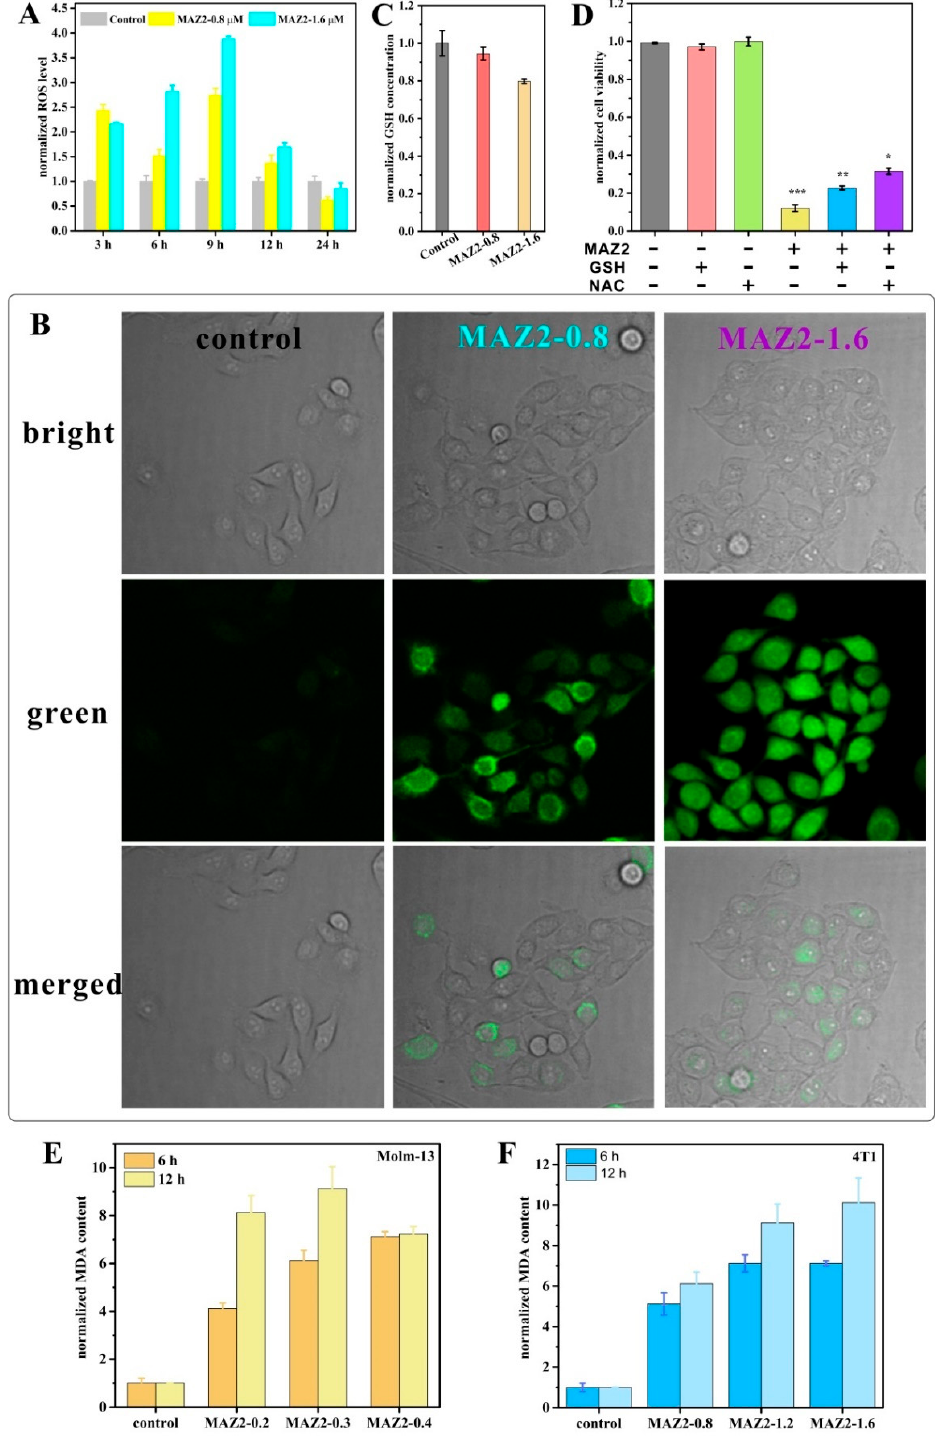
Figure 2. ROS bursting after TrxR inhibition by arsenicals; ( A ) is the fluorescence intensity of the 4T1 cells stained by DCFH-DA (the fluorescence was detected by flow cytometry); ( B ) is the 4T1 cells stained by DCFH-DA (the fluorescence was detected by confocal); ( C ) is the GSH contents; ( D ) is the cell viability under MAZ2 treatment without GSH or NAC; and ( E , F ) are the MDA contents of the Molm-13 and 4T1 cells. Significance was set at * p < 0.05, ** p < 0.01 and *** p < 0.001